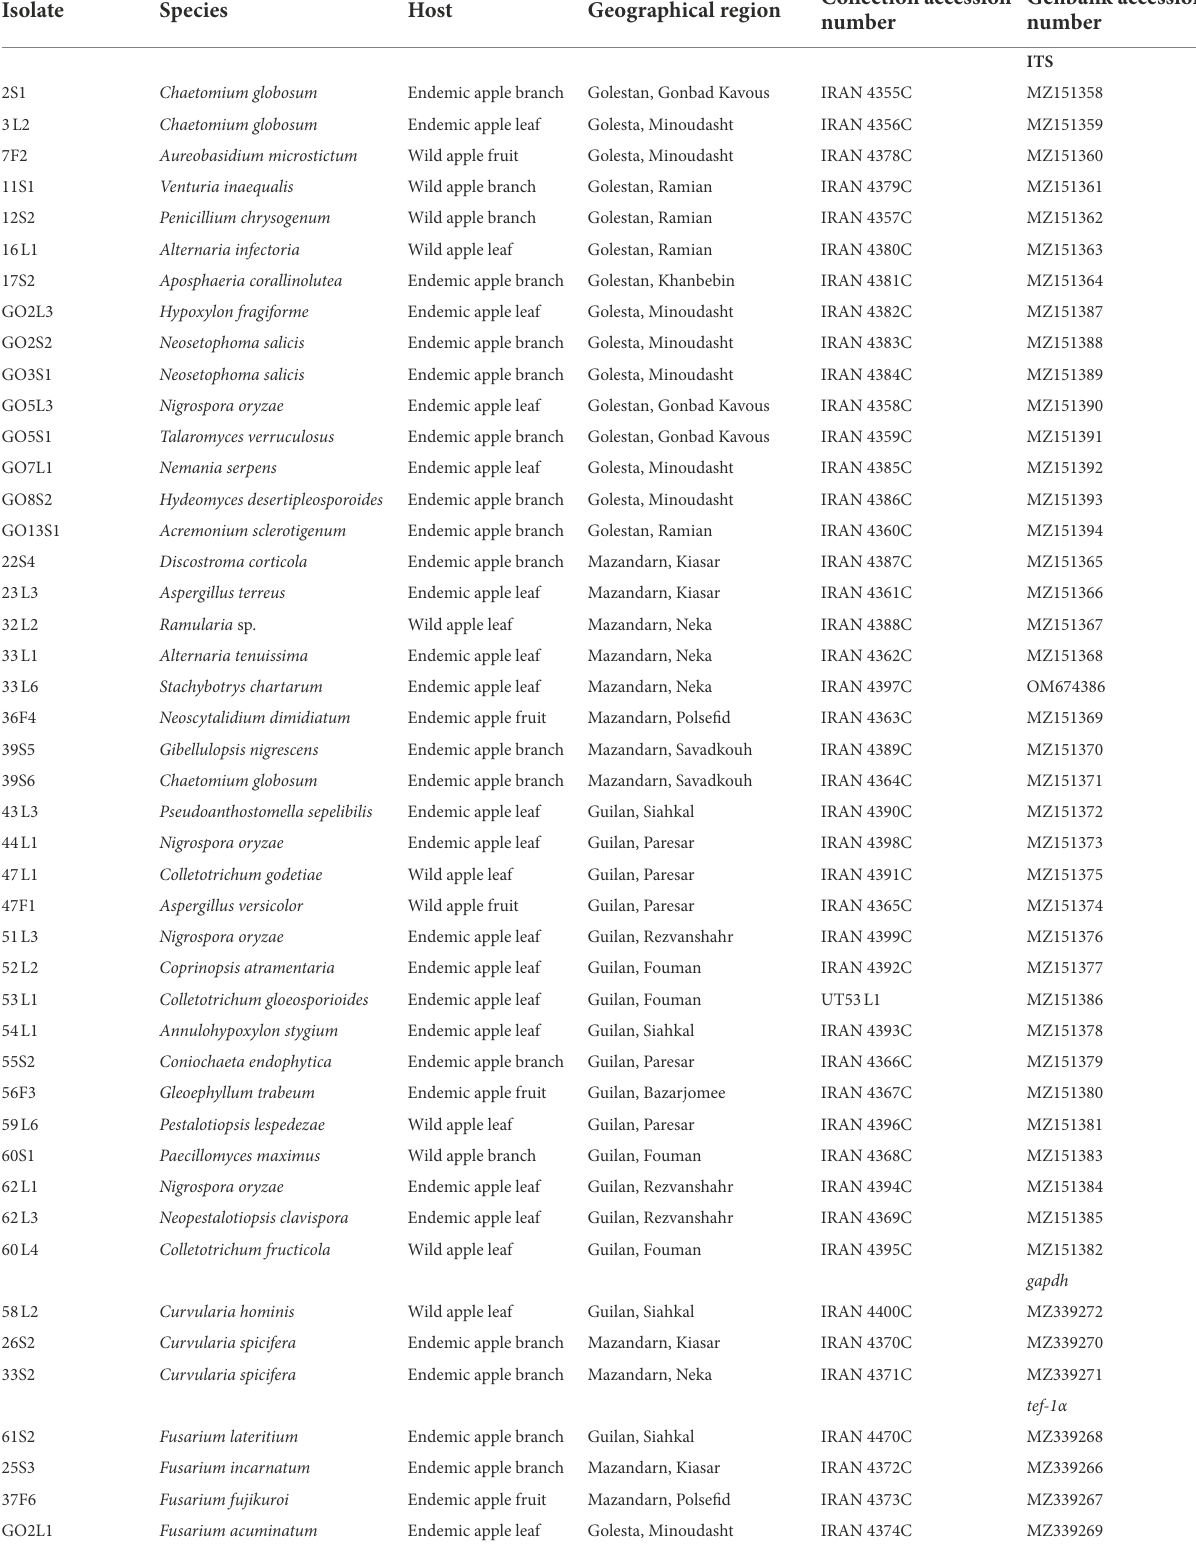
TABLE 1 Identified endophytic fungi of Iranian endemic and wild apple based on morphology and by ITS, translation elongation factor 1-alpha ( tef-1 α ) and glyceraldehyde-3-phosphate dehydrogenase ( gapdh ) sequences. Isolate